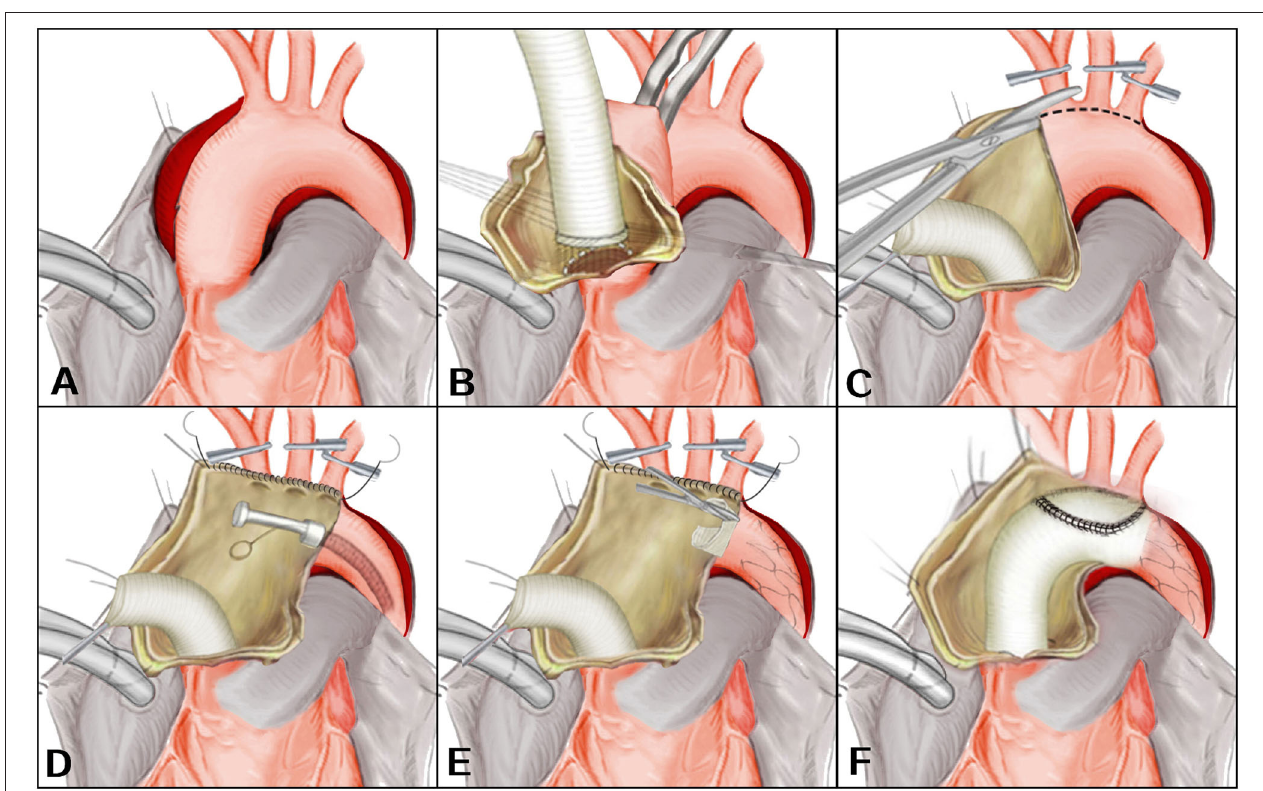
FIGURE 1 | (A–F) En bloc reconstruction with the frozen elephant trunk technique. Revised from Jun-Ming Zhu,